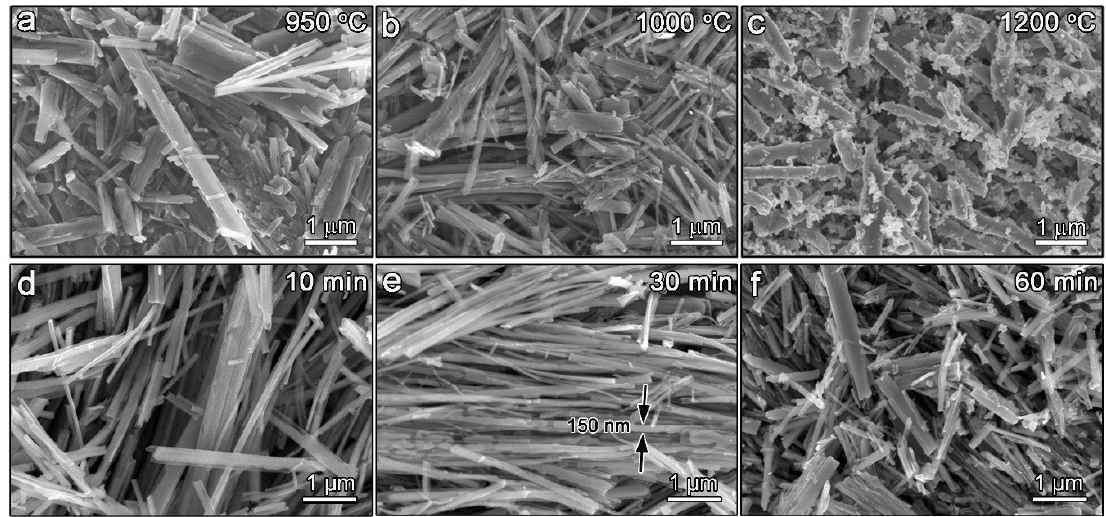
Figure 1. SEM images of T4/T3 nanofibers with ( a – c ) different calcination temperatures and ( d – f ) holding times. holding